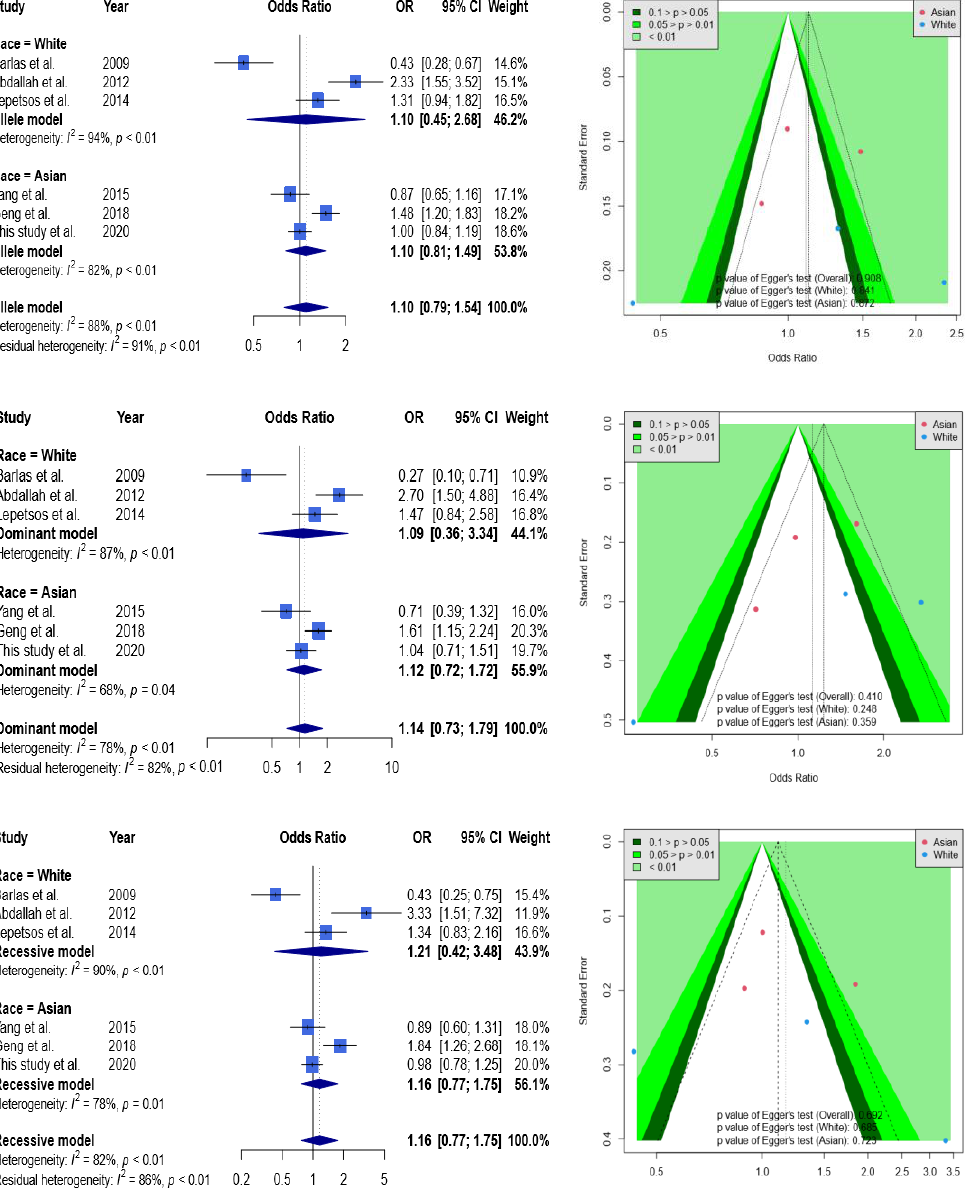
Figure 2. Forest plot and funnel plot regarding the association between MMP1 rs1799750 and knee OA. Selected results from the meta-analysis of MMP1 rs1799750 and knee OA. The top left subplot is a forest plot based on an allele model assumption (reference: 1G allele) and the top right subplot is a funnel plot based on the allele model assumption. The results obtained with the dominant (1G1G + 1G2G vs. 2G2G) and recessive (1G1G vs. 2G2G + 1G2G) models are presented at the middle and bottom. All results are